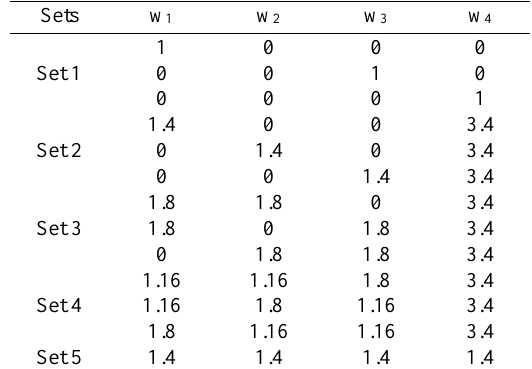
Table 1. Weighting scenarios for motif ranking.